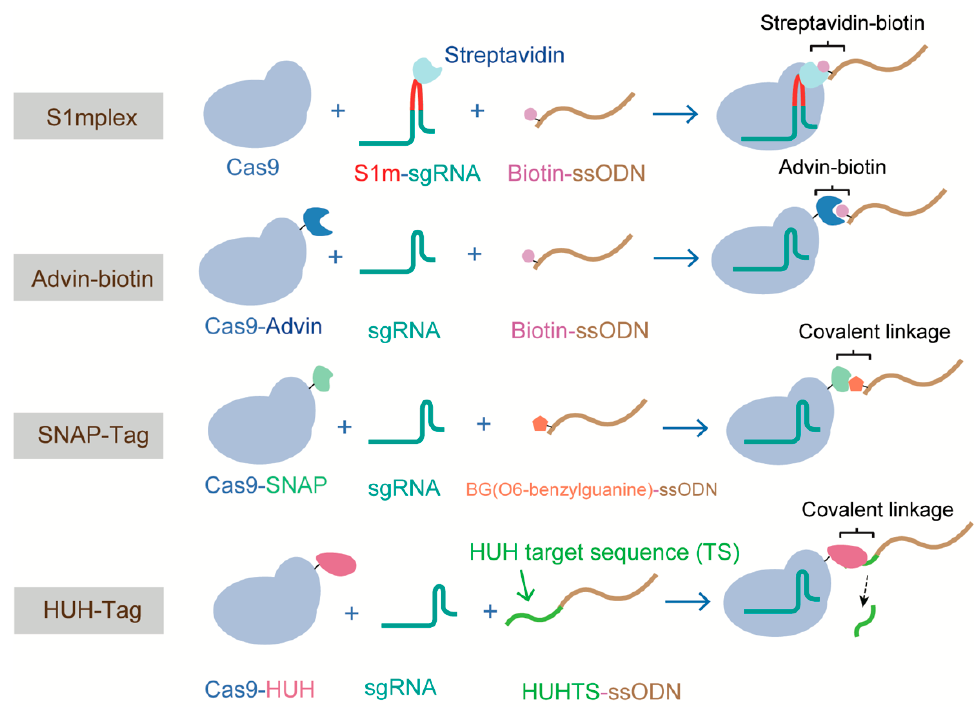
Figure 7. Methods tethering a ssODN donor template to Cas9 RNP, forming the all components in one HDR complex .